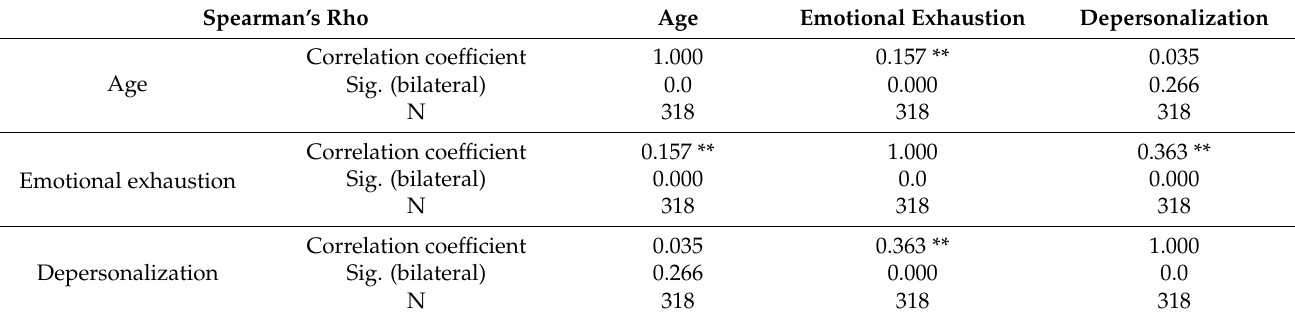
Emotional exhaustion